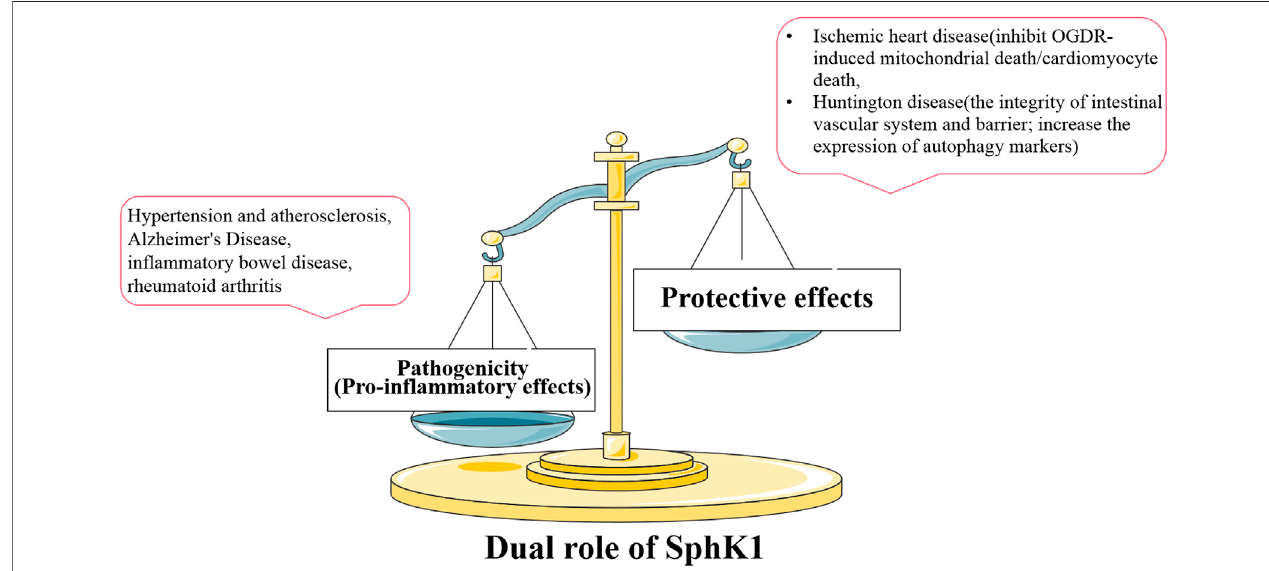
FIGURE 6 | Relationship between the expression and activity of SphK1 and dual role in disease. SphK1 plays different roles in different diseases. In most in fl ammatory diseases, the increase of pathogenic SphK1 expression intensi fi es the development of the disease, and SphK1 inhibitors play a therapeutic effects. The decreasedexpression oractivity ofSphK1, whichhas aprotectiveeffect inotherdiseases, contributes tothedevelopmentofthe otherdiseases(such asischemic heart disease and HD). Therefore, normal SphK1 level is very important for the stability of body function.